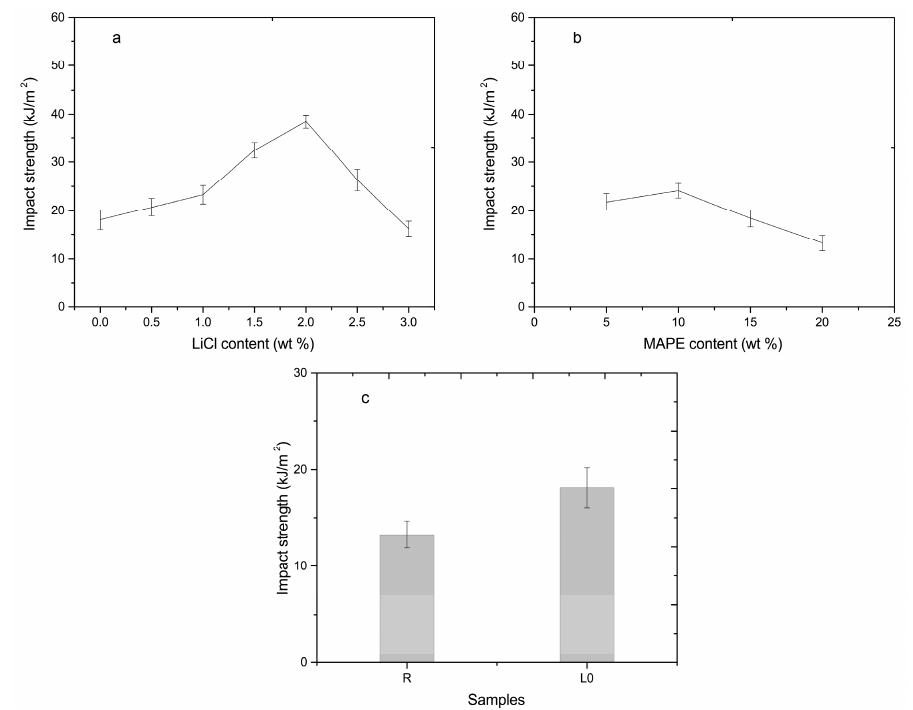
Figure 4. Impact properties of composites: ( a ) in various LiCl contents; ( b ) in various MAPE contents; and ( c ) PA6/MCC composites and PA6/HDPE/MCC composites without LiCl.